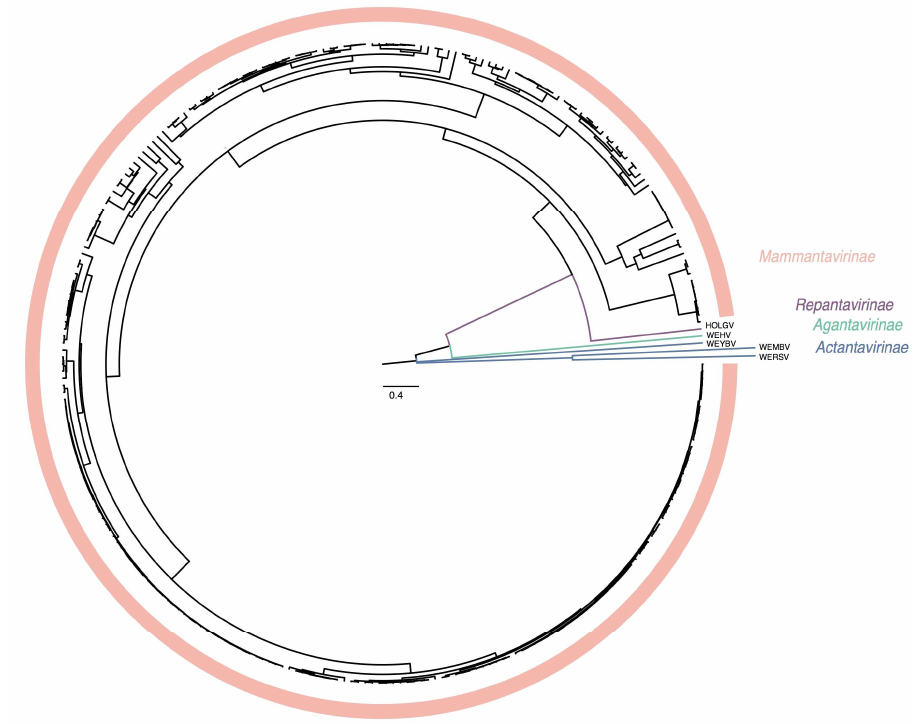
Figure 3. Bayesian inference of concatenated S and M segment-encoded protein amino acid sequences of Hantaviridae . A maximum clade credibility tree of the complete amino acid sequence of the hantavirid S and M segment-encoded proteins divides the family into four subfamilies. Table 3. Classification overview of Hantaviridae in 2019 [ 32 ] .